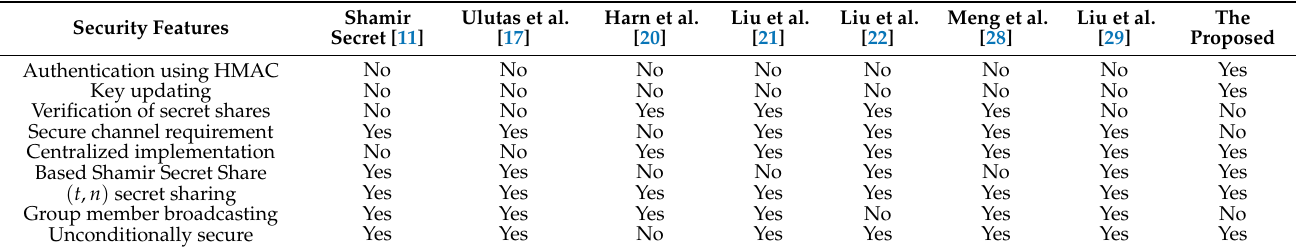
Table 4. Security features comparison for the proposed key management protocol and other shared secret related